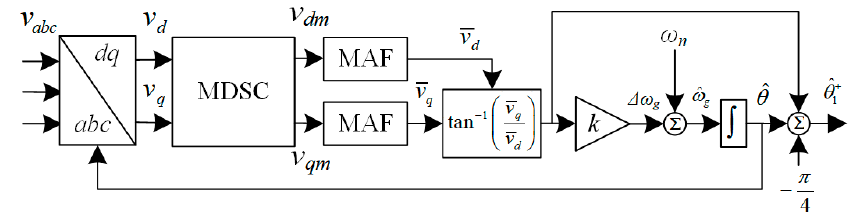
Figure 11. Block diagram of the proposed PLL.